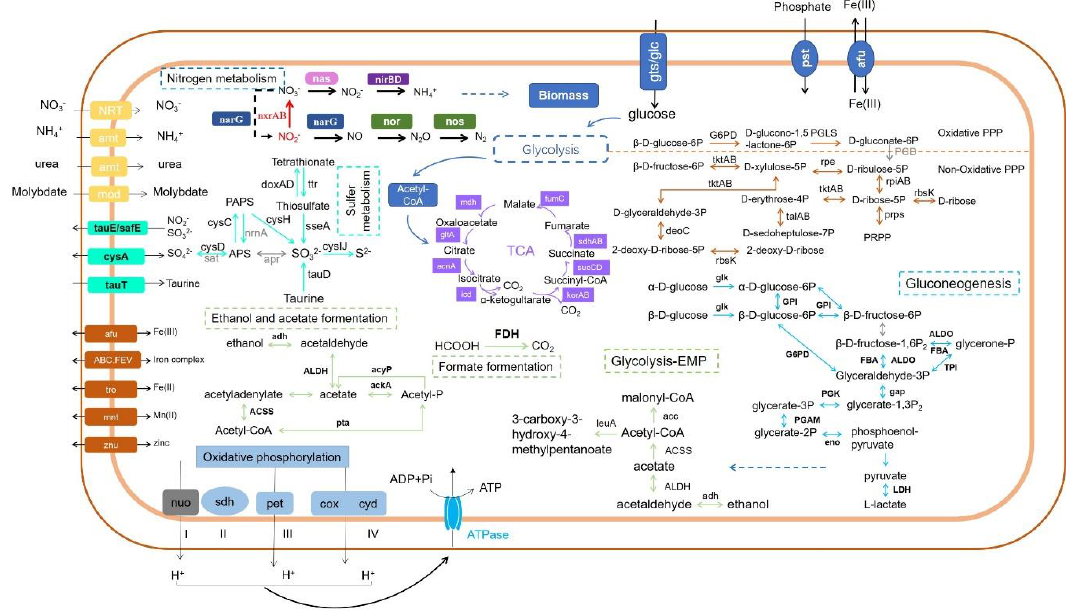
Figure 3. Metabolic capabilities of Halomonas sp. strain 3727. Pathways associated with carbon, nitrogen, and sulfur are shown, along with oxidative phosphorylation, fermentation, and ion transportation.